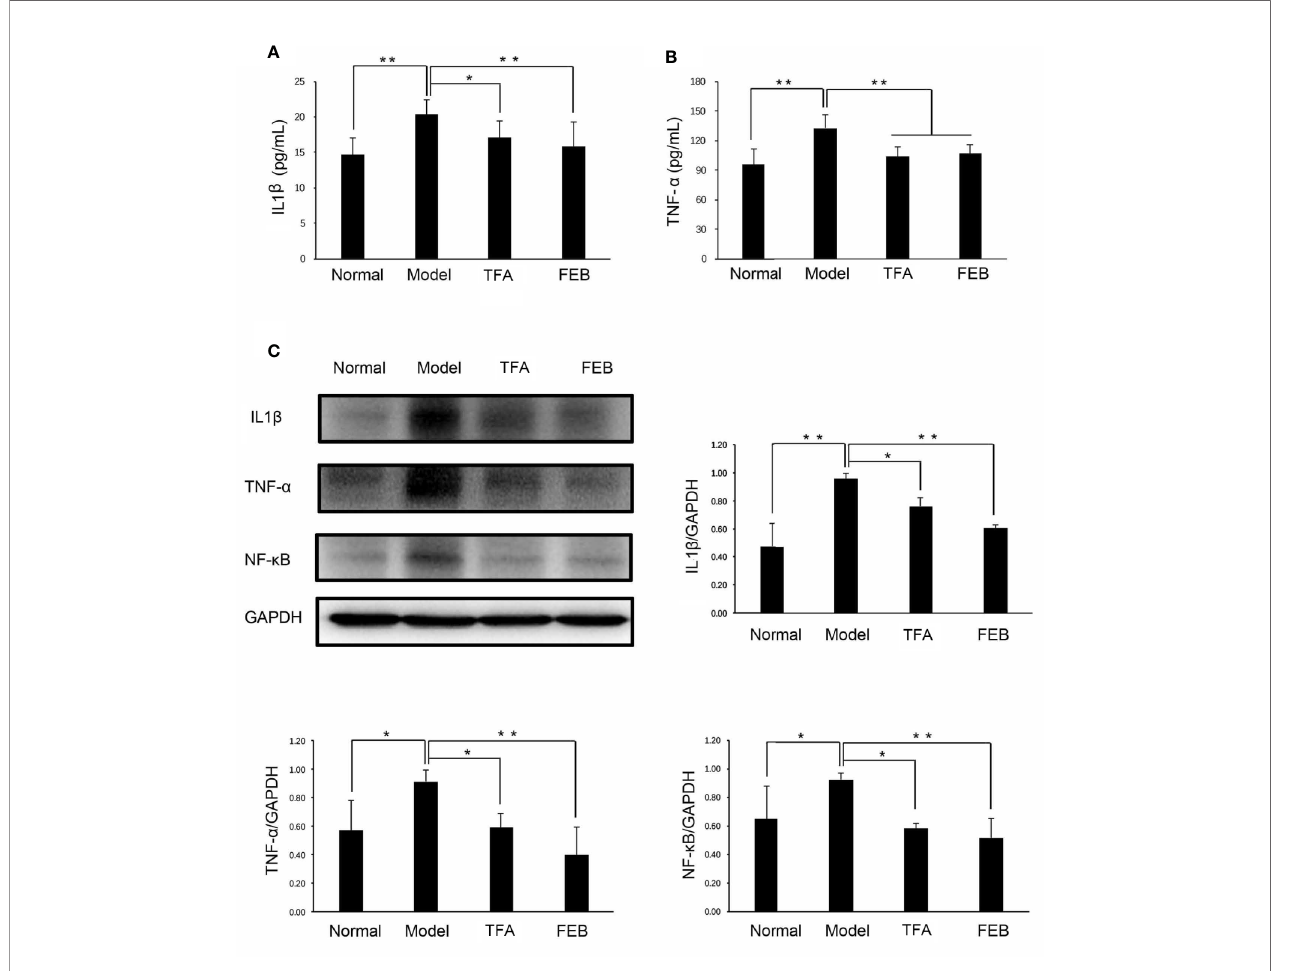
FIGURE 4 | Effects of TFA and FEB on microin fl ammation. (A, B) Serum levels of IL1 b and TNF- a in the Normal, Model, TFA, and FEB rat groups. (C) A WB analysis of IL1 b , TNF- a , and NF- k B in the kidneys of the Normal, Model, TFA, and FEB rats. The data are expressed as the mean ± SD (n = 3), * P < 0.05, ** P < 0.01. TFA, total fl avones of Abelmoschus manihot ; FEB, febuxostat; IL1 b , interleukin 1 b ; TNF- a , tumor necrosis factor- a ; NF- k B, nuclear factor- k B; WB, Western